Question: Produce a descriptive caption suitable for publication.
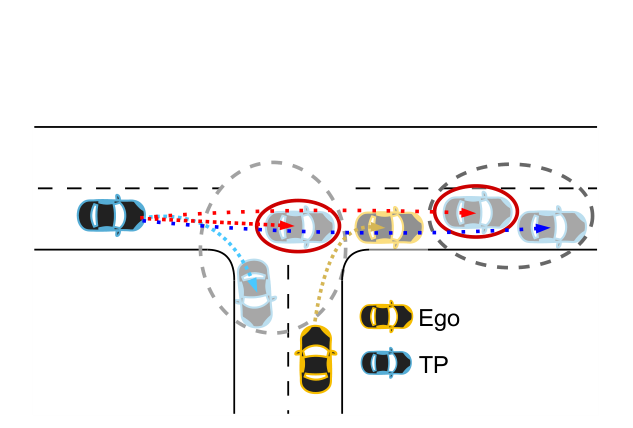
Answer: Illustration of the Scenario Selection procedure. Predictions enclosed in grey ellipses belong to same cluster. Red ellipses mark scenarios selected from each cluster.